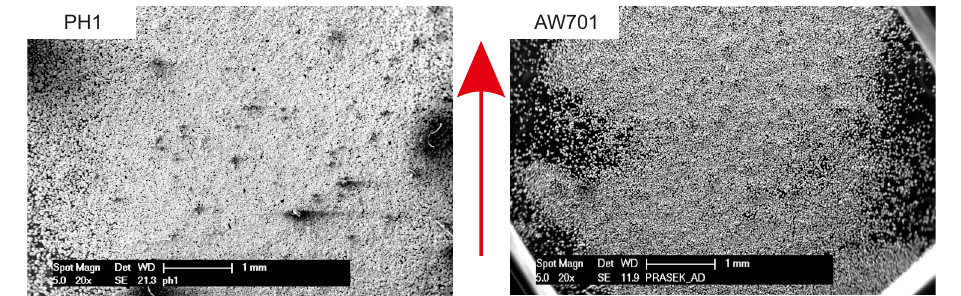
Figure 3. Size distribution for the two studied powders [36].